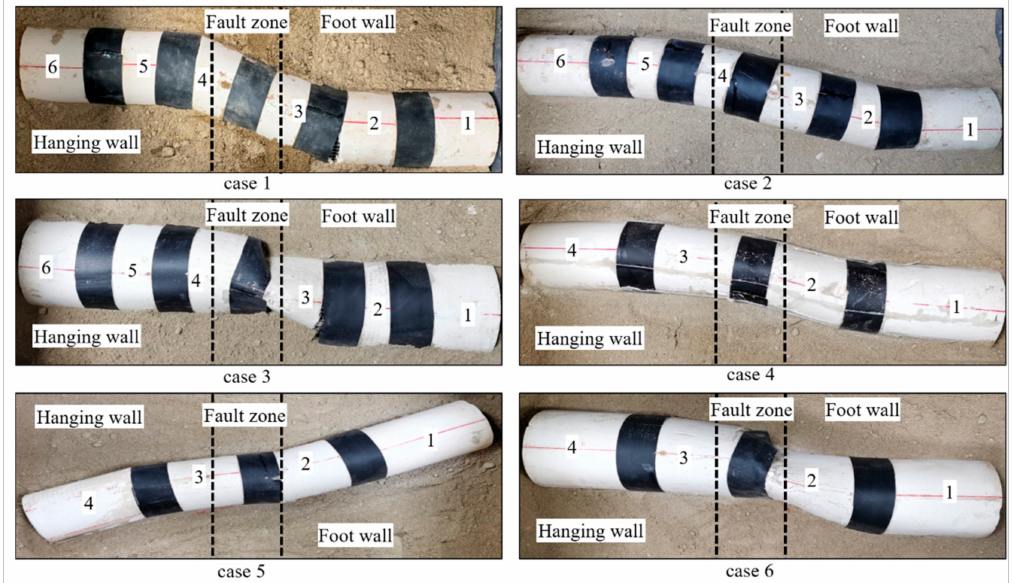
Figure 14. Deformation of lining structure of each